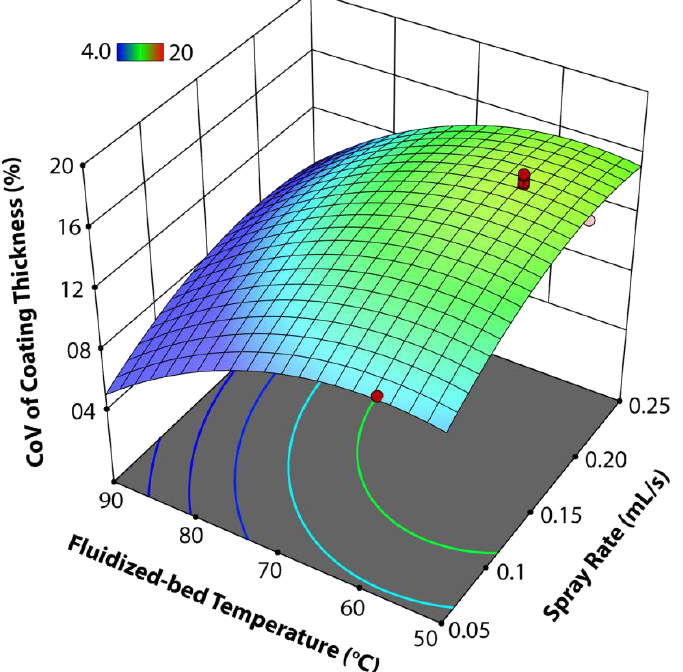
Figure 4. Interactive effect of the fluidized-bed temperature ( T fb ) and spray rate ( R spray ) on the CoV of coating film thickness.